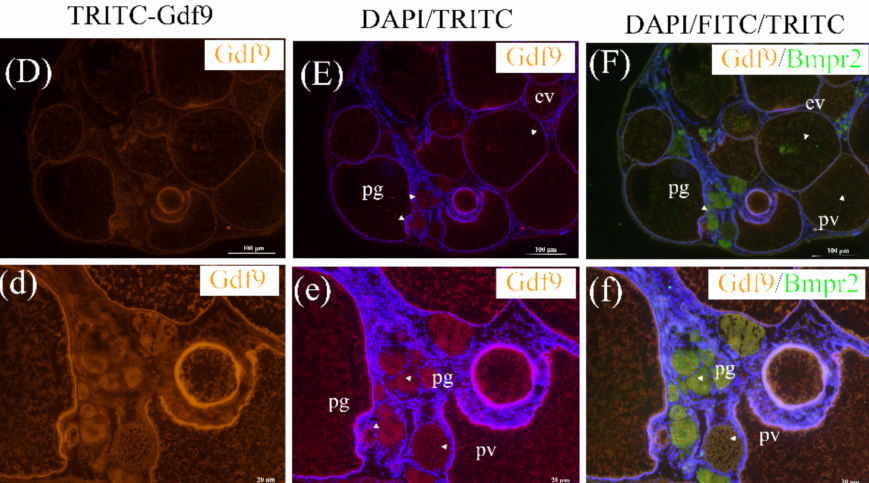
Figure 5. Immunofluorescence analysis of Bmpr2 and Gdf9 in the ovary of ricefield eel, Monopterus albus . Fluorescent images of Bmpr2 in the ovary captured by FITC: ( A , a ), DAPI; ( B , b ), FITC; ( C ), merged fluorescent images of ( A , B ). ( c ), Merged fluorescent images of ( a , b ). Fluorescent images of Gdf9 in the ovary captured by TRITC: ( D , d ), TRITC; ( E ), merged fluorescent images of ( A , D ); ( e ), merged fluorescent images of ( a , d ); ( F ), merged fluorescent images of ( C , E ); ( f ), merged fluo- rescent images of ( c , e ). PG, primary growth stage; PV, previtellogenic stage; EV, early vitellogenic stage. Immunofluorescence (green) shows Bmpr2 expression in the ovary. Immunofluorescence (orange-red signal) shows Gdf9 expression in the ovary. Nuclei are labeled with DAPI (blue). All photomicrographs were taken by an Olympus inverted research